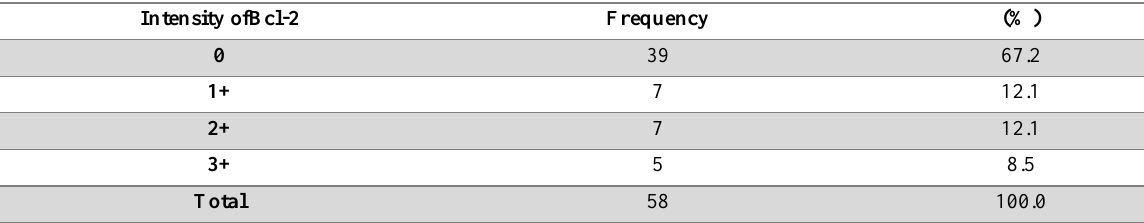
Table 1 . Intensity of Bcl-2 in colorectal carcinoma Intensity ofBcl-2